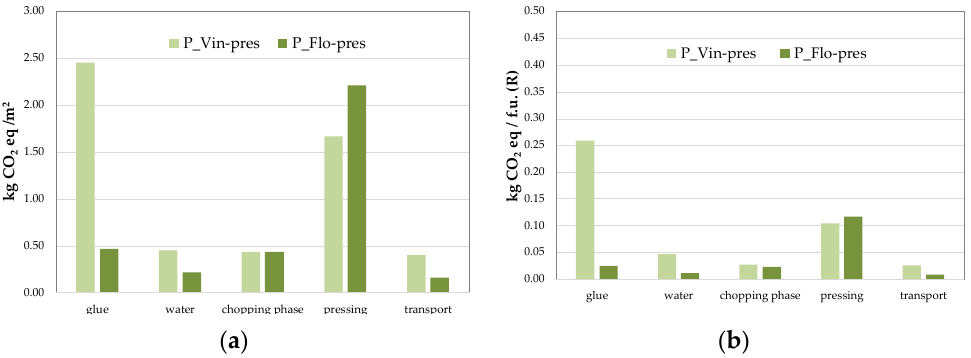
Figure 8. Global warming potential calculated for the different phases for both the panels (P_Vin-pres and P_Flo-pres): f.u. equal to 1 m 2 ( a ); f.u. equal to R = 1 m 2 K/W ( b ). Table 3. Comparison between the global warming potential of different insulating materials (in bold data from the present paper)